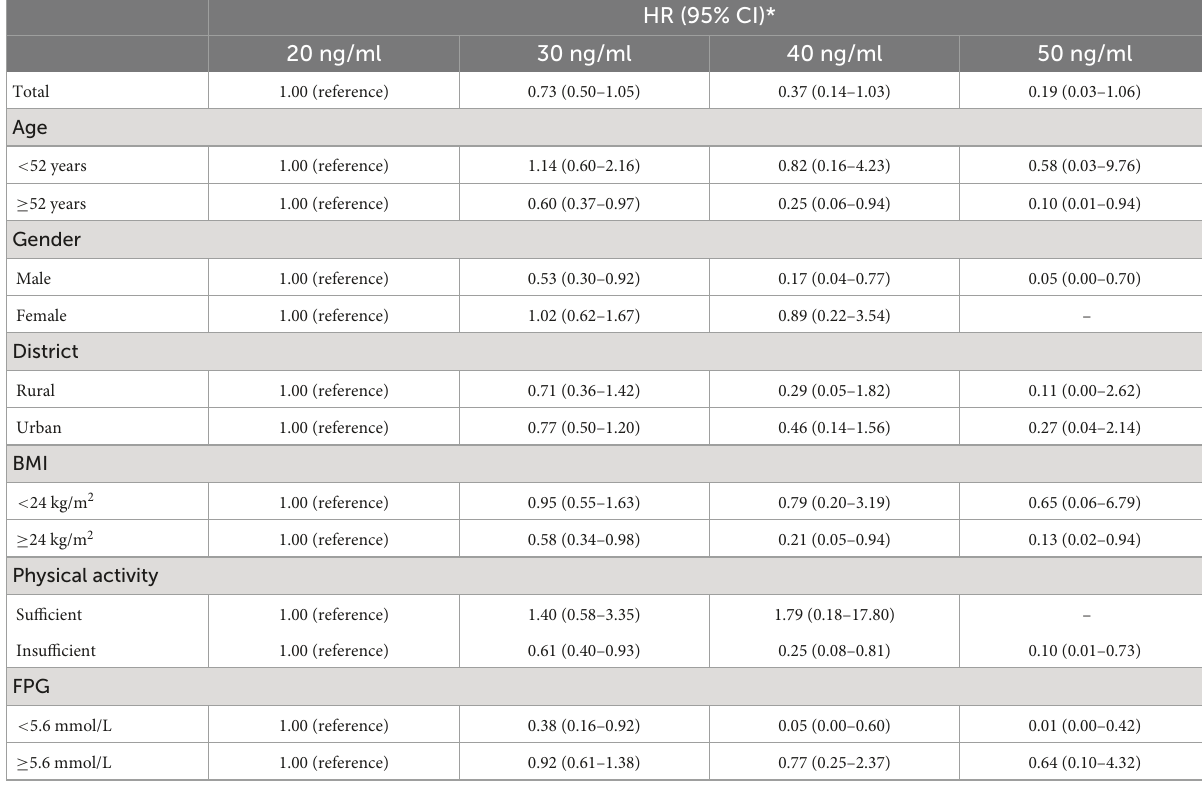
TABLE 3 Hazard ratios (95% CIs) of type 2 diabetes by serum 25(OH)D